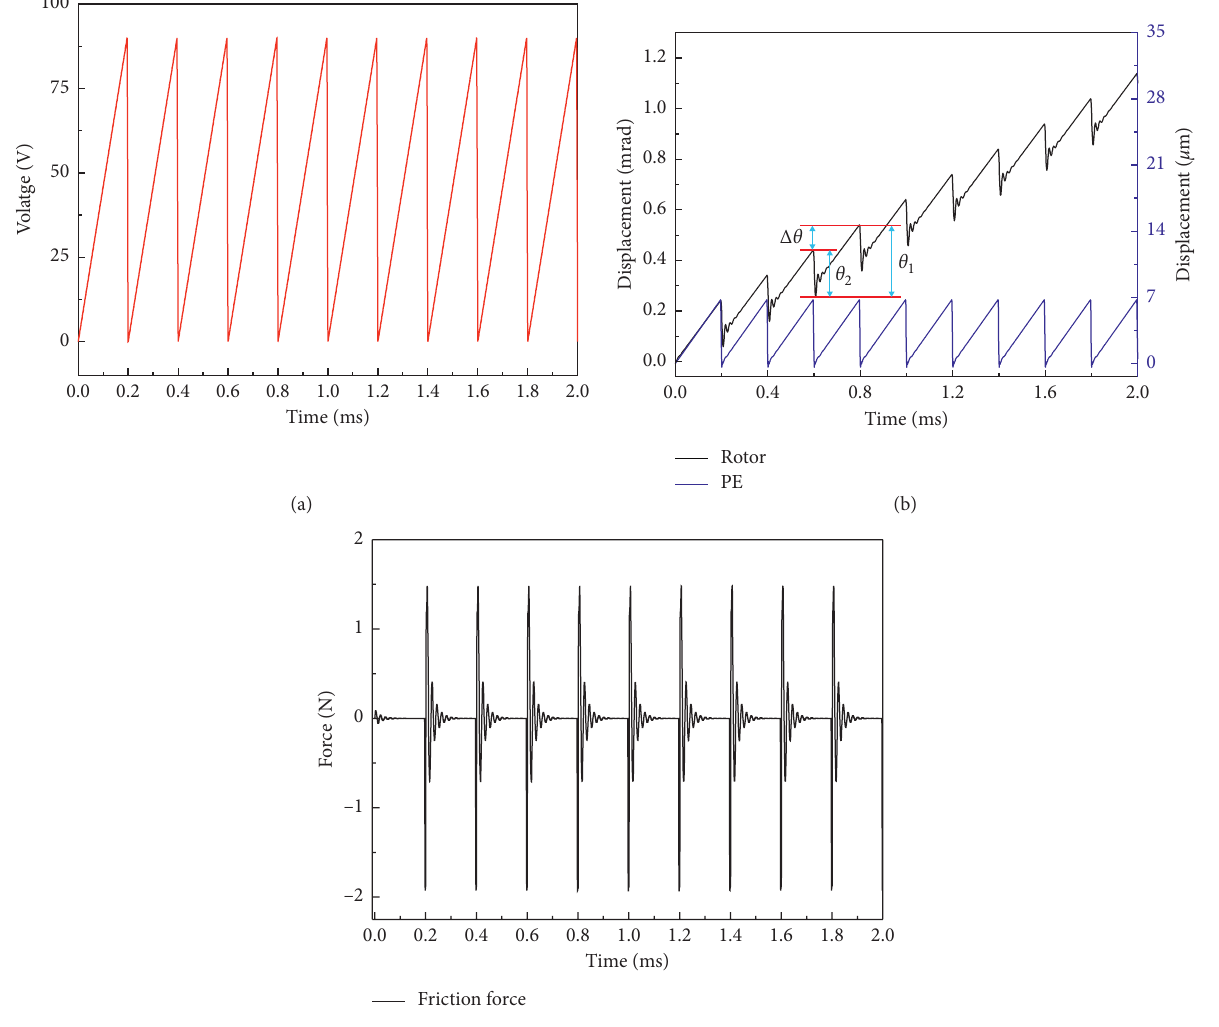
Figure 6: Simulation results under sawtooth signal of 500Hz 90 V. (a) Driving voltage. (b) Displacement. (c) Friction force.